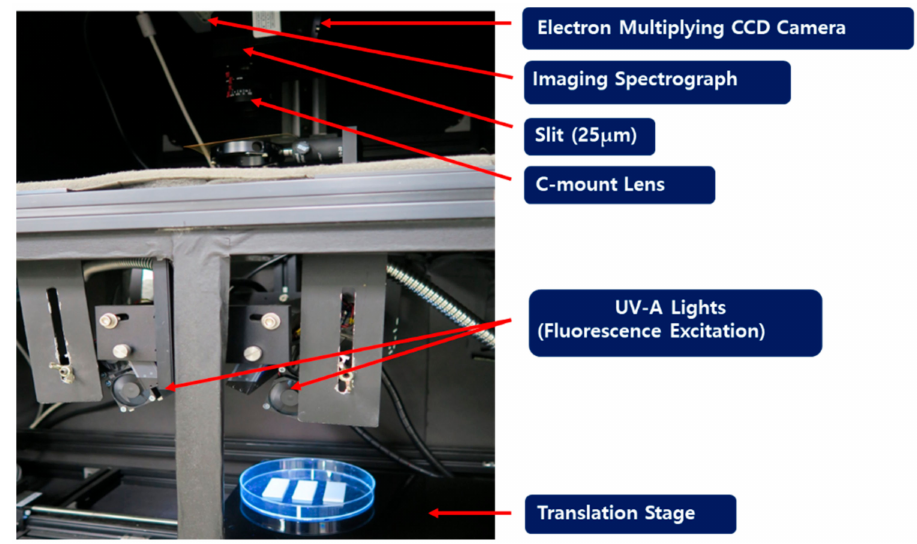
Figure 2. The ultraviolet fluorescence hyperspectral imaging